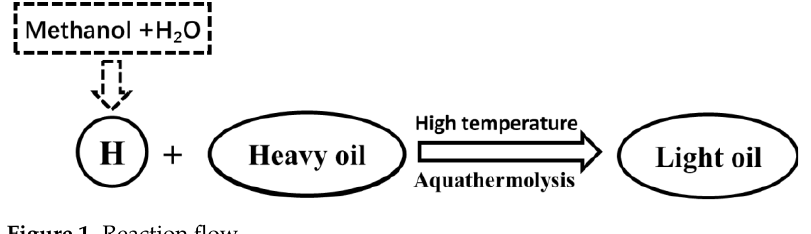
Figure 1. Reaction flow.